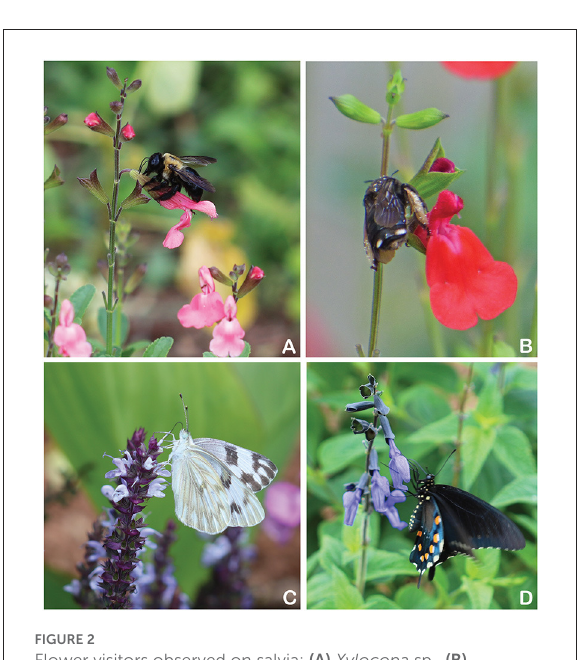
FIGURE2 Flower visitors observed on salvia: (A) Xylocopa sp., (B) Melissodes sp., (C) Pieridae, and (D) Papilionidae.